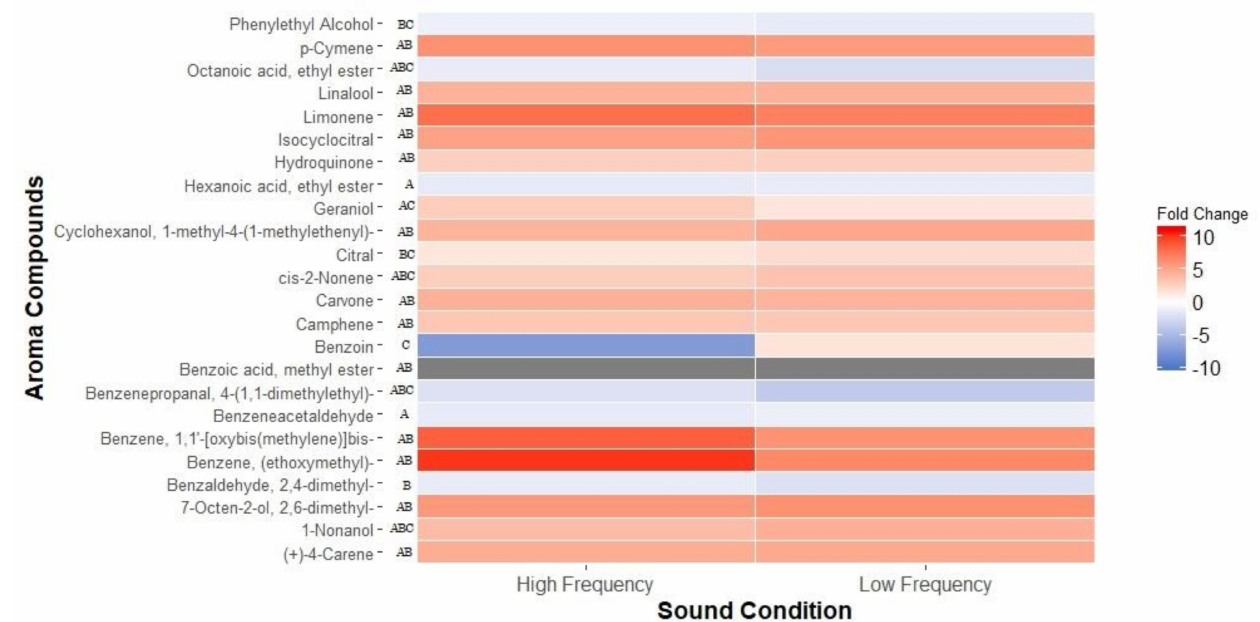
Figure 2. Fold changes of aroma-associated volatile metabolite levels produced when exposed to high-frequency (10 kHz) and low-frequency (Hz) sound when both are compared to silence. Data are displayed as a heat-map (right), with red- shade indicating increased abundance blue-shade indicating decreased abundance (compared to silence). The pairwise significance for each compound was assessed using a post-hoc Tukey ANOVA ( p < 0.05); A- high-frequency versus silence, B- low-frequency versus silence, C- high-frequency versus low-frequency. Methyl benzoate, grey, was outside the range of our scale, with significantly higher abundance for both high-frequency and low-frequency sound treatments (33- and 30-fold,